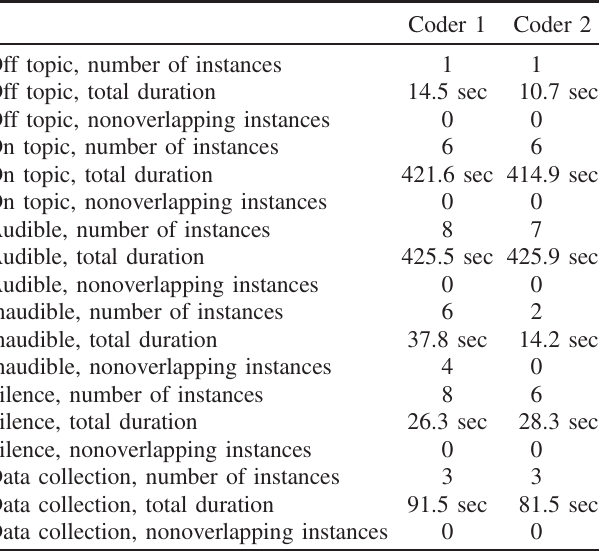
TABLE I. Details of interrater coding for a 10 min sample of